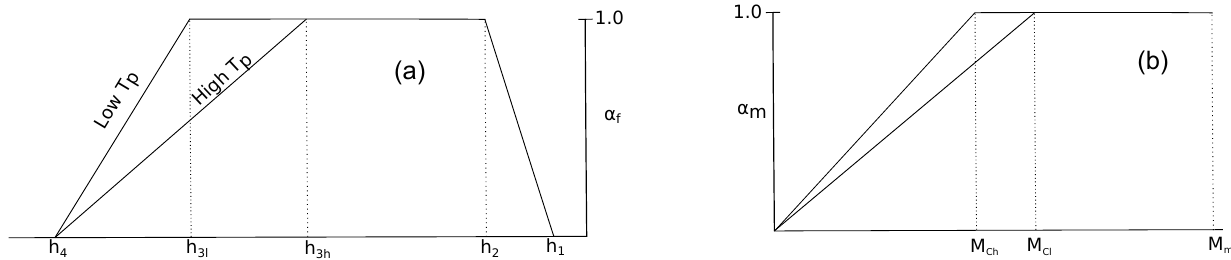
Figure 1. (a) Feddes et al. (1978) root water uptake reduction function. h 2 and h 3 are the threshold parameters for reduction in root water uptake due to oxygen deficit and water deficit, respectively. The subscripts l and h stand for low and high potential transpiration T p . h 1 and h 4 are the soil pressure head values above and below which root water uptake is zero due to oxygen and water deficit, respectively. (b) Root water uptake reduction function α m as a function of matric flux potential M ; M ch and M cl are the critical values of M for high and low T p , respectively, below which the uptake is reduced and M max is the maximum value of M , dependent on soil